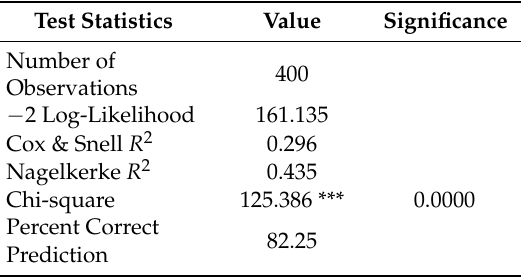
Table 3. Statistical test for suitability of the